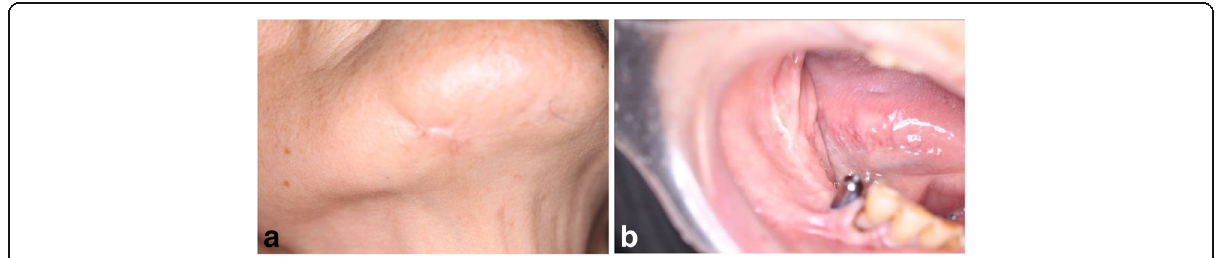
Fig. 5 a Extraoral photograph 5 months after the sequestrectomy. b Intraoral photograph 5 months after the